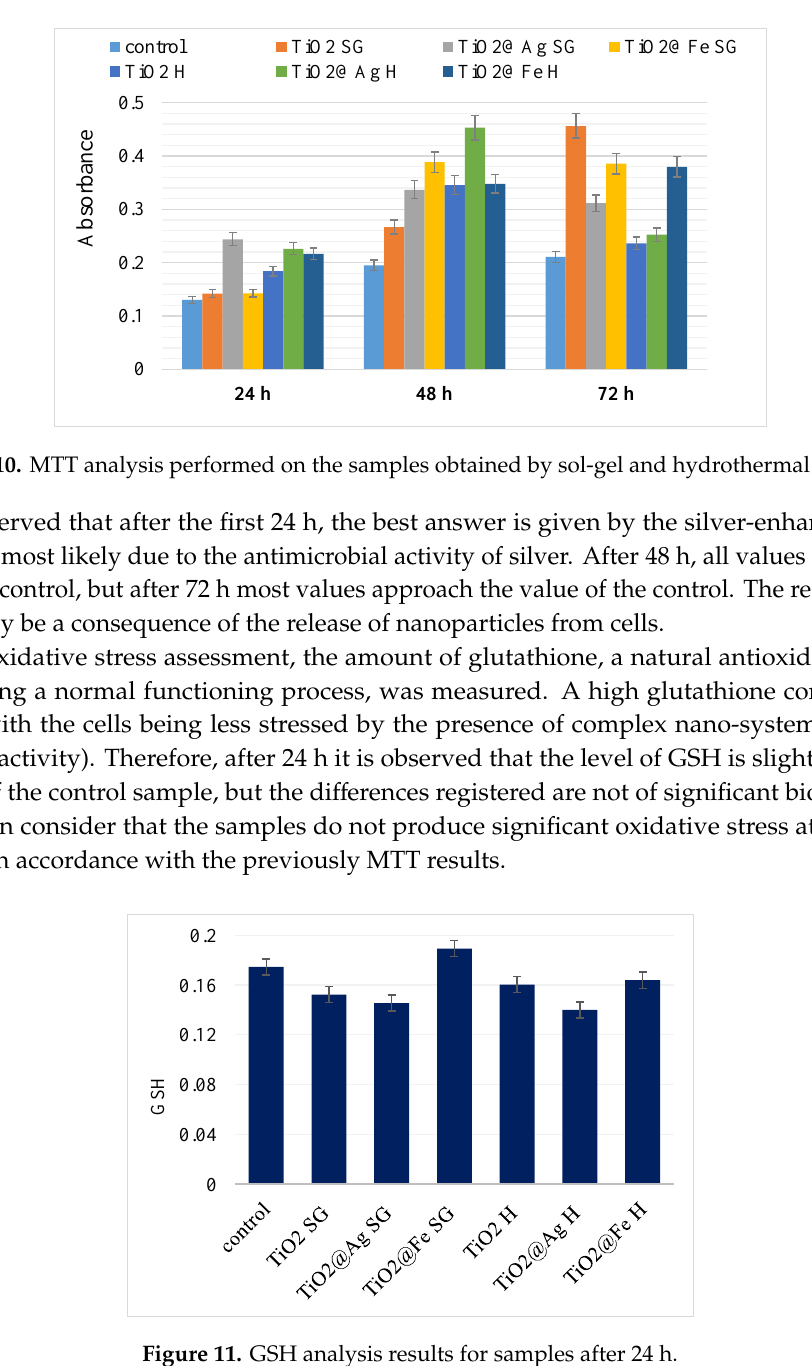
Figure 9. The TEM and HRTEM images ( a ), SAED patterns ( b ) and particle size distribution ( c ) corresponding to TiO 2 @Fe SG sample.